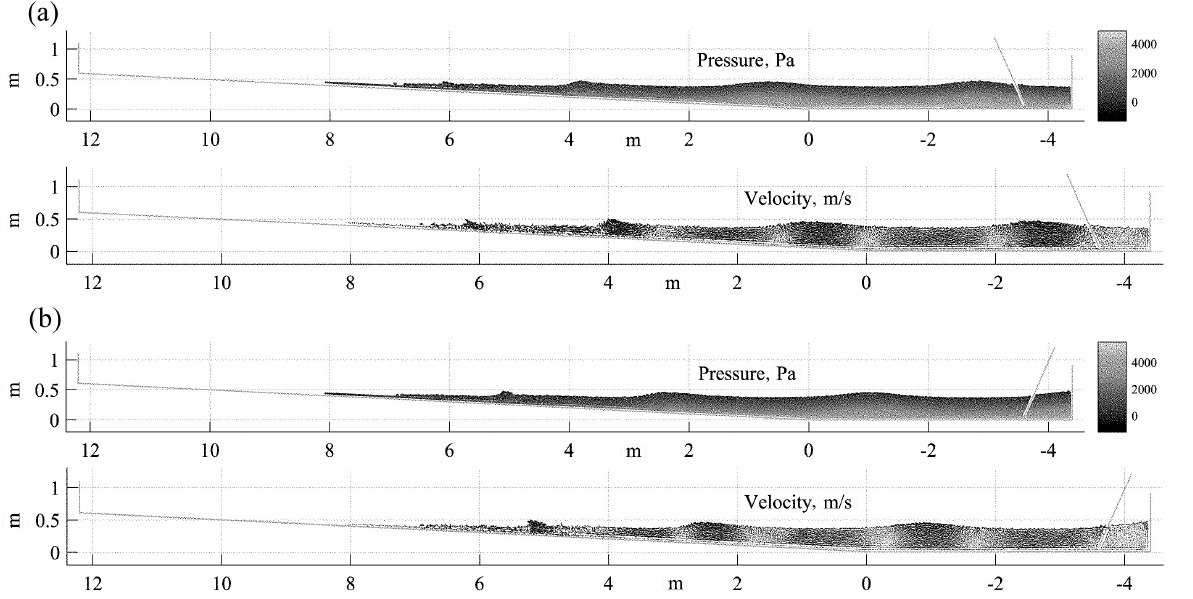
Fig. 2. SPH simulations of surface waves using an oscillating plate in: a) upper sub-plot shows the pressure and lower sub-plot shows the velocity at the time instant after 106.5 s; b) upper sub-plot shows the pressure and lower sub-plot shows the velocity at the time instant after 107.5 s.